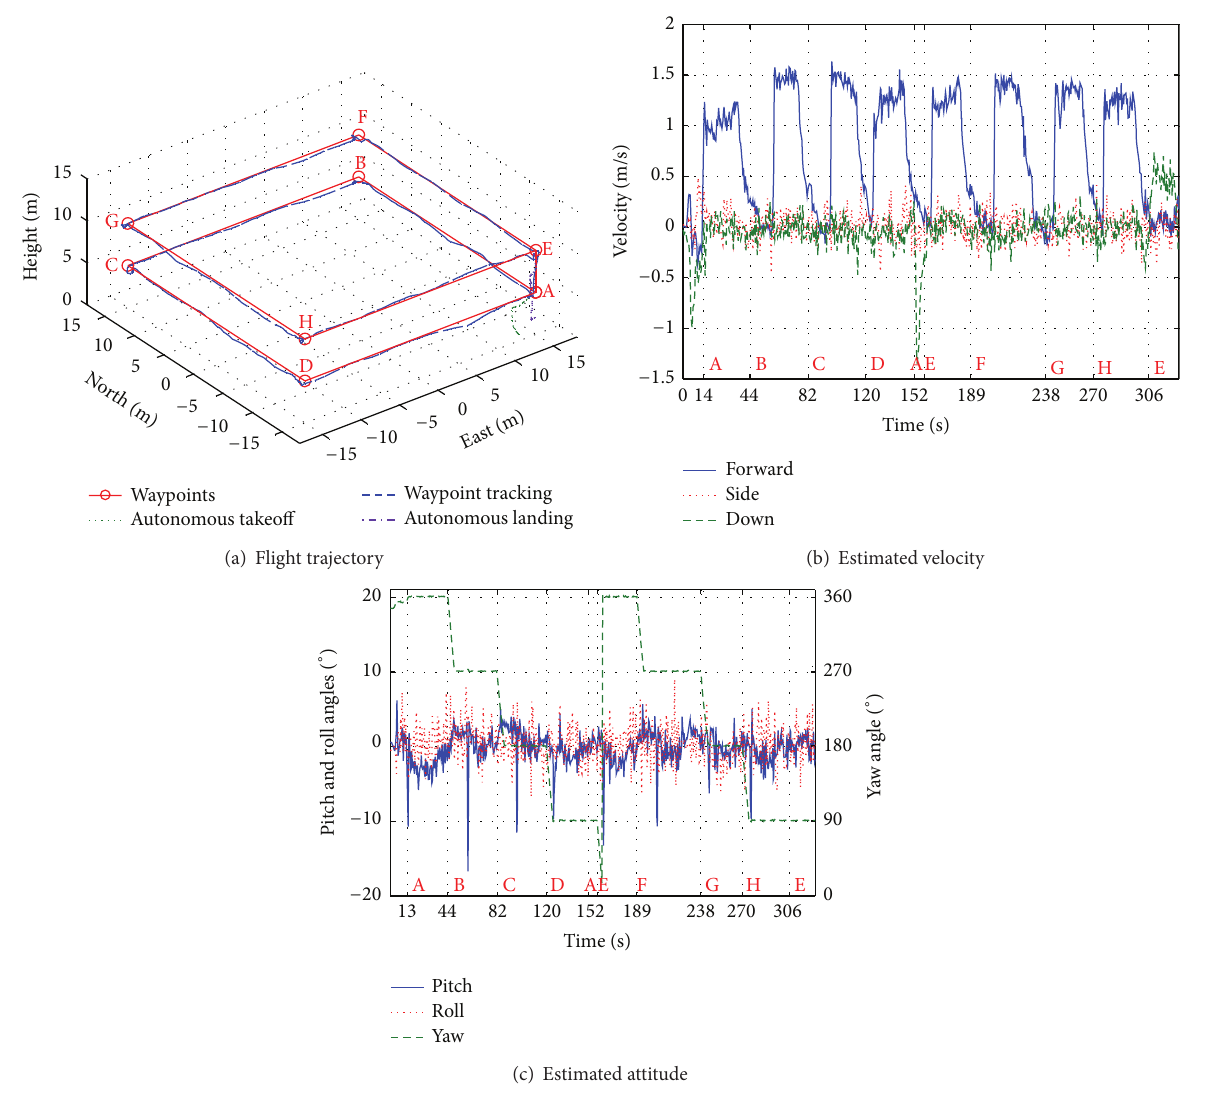
Figure 15: Estimated flight states of quadrotor in waypoint